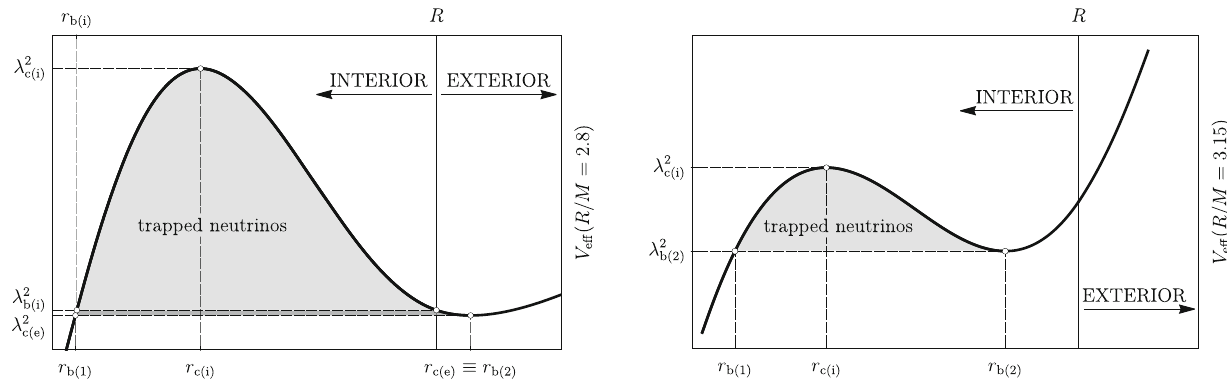
Fig. 2 The effective potential of the Tolman VII spacetimes with R = 2 . 8 M (left panel) and R = 3 . 15 M (right panel). The trapped area is light shaded for the internal trapped null geodesics and dark shaded for the external trapped geodesics / d r 2 = 0 which implies the rela- additional condition d 2 V int eff